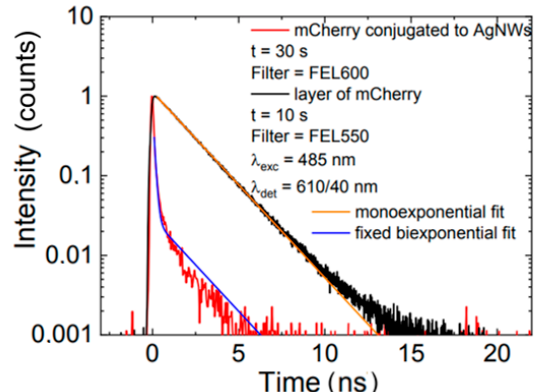
Figure 5. Fluorescence intensity decay measured for mCherry on glass (black line) and conjugated to AgNWs (red line).